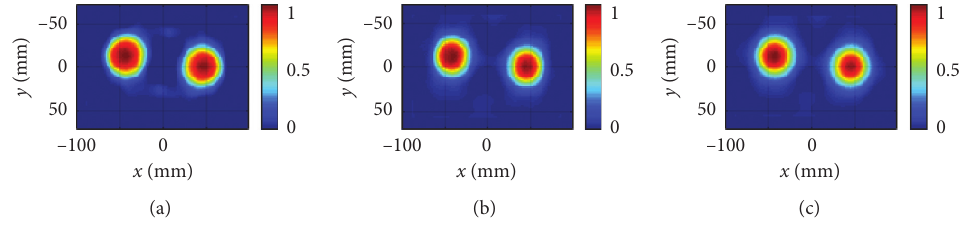
Figure 10: The imaging results of double scatterers.